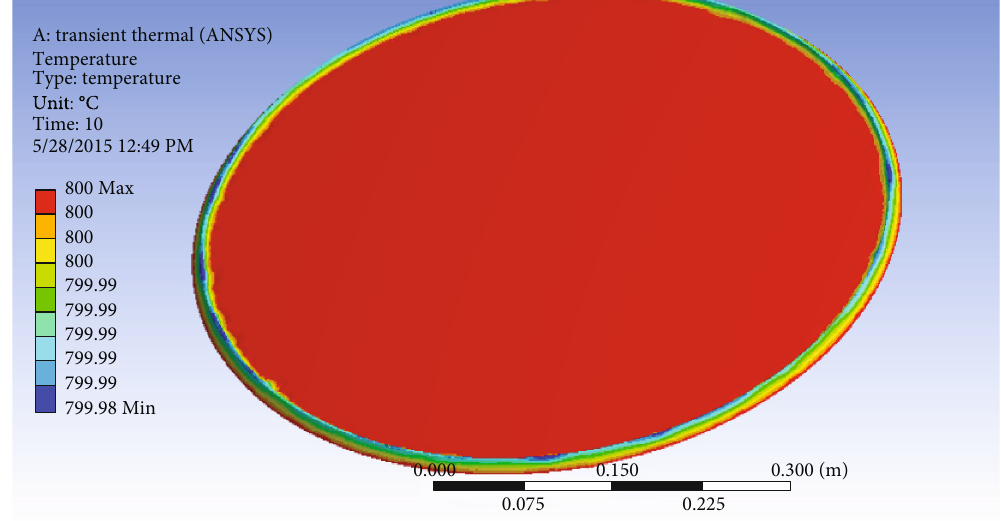
Figure 10: Transient thermal analyses over the mitad.